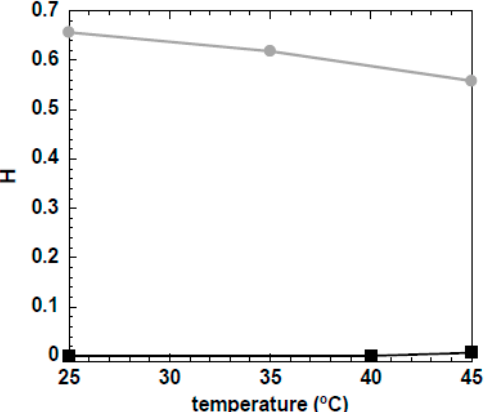
Figure 6. Variation of the H parameter with temperature for the 5 wt % (black squares) and 10 wt % (grey circles) MCC samples dissolved in 8 wt % NaOH(aq.)/12 wt % urea.